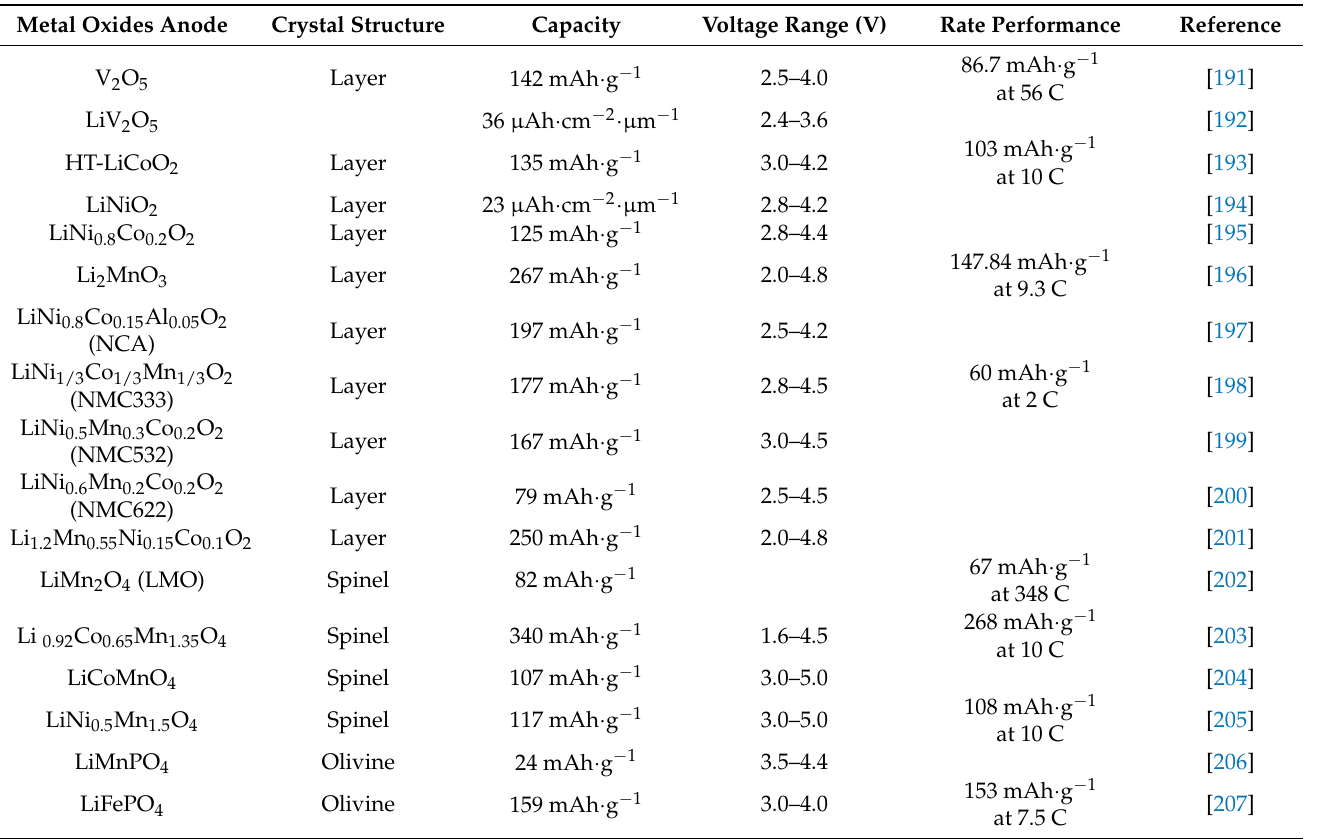
Table 3. Various cathode materials for